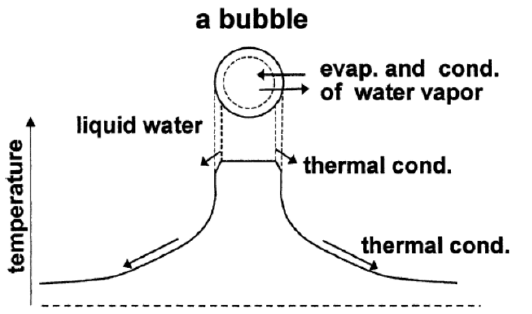
Figure 2. The model of bubble dynamics. Reprinted with permission from Ref. [75]. Copyright 2004, Elsevier.